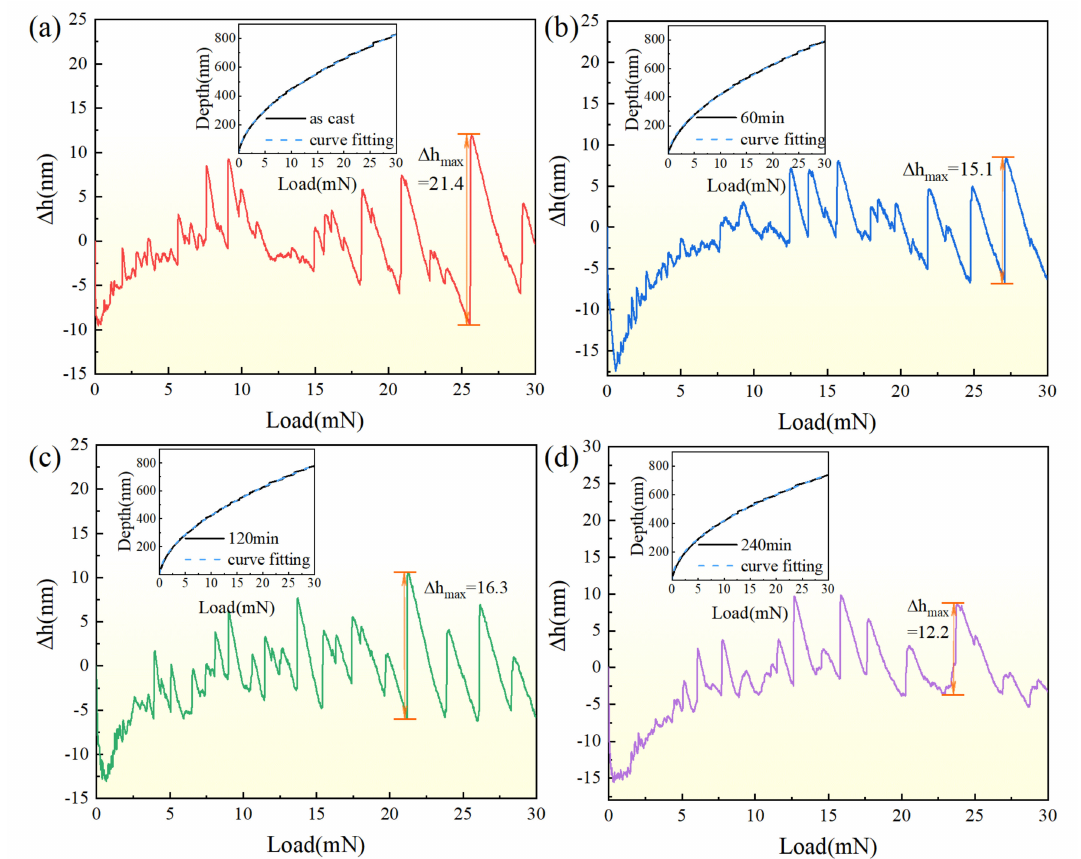
Figure 5. Variations of the length of serration ∆ h on the load at the loading stage for the as-cast and annealed La 65 Al 14 Ni 5 Co 5 Cu 9.2 Ag 1.8 BMG and the fitted baseline for depth-load curve in the inset: ( a ) as-cast; ( b ) 60 min; ( c ) 120 min; ( d ) 240